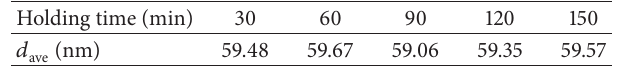
Table 3: Relative intensity of X-ray diffractions and standard card. ℎ𝑘𝑙 Experimental Rel.Int. (%)